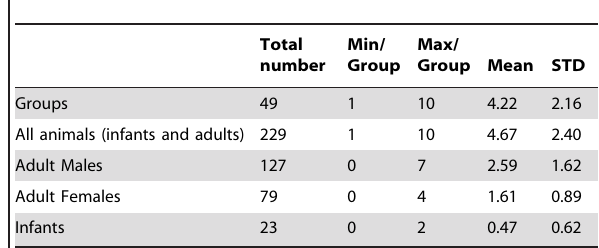
Table 1. Descriptive statistics of the sifaka counted and sexed at Berenty in 2006: total number of groups and individuals, number of adult males and females, and number of infants; minimum, maximum and standard deviation (STD) of the number of individuals (of both sexes), males, females, and infants per group